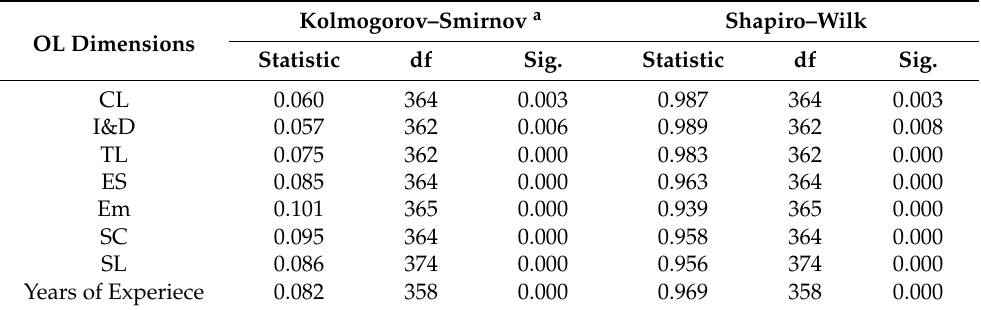
Table 1. Normality tests for organizational learning (OL) dimensions and for Years of Experience. OL